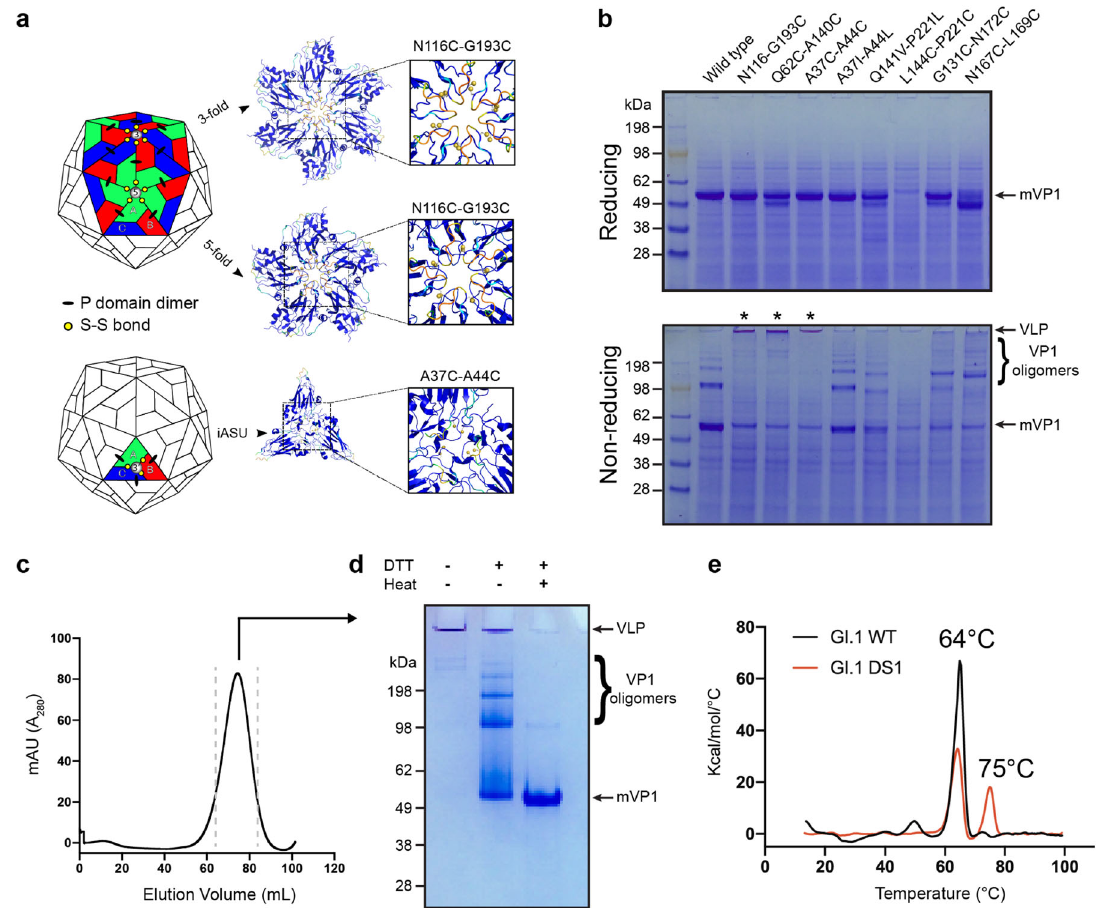
Fig. 2 Structure-based design of interprotomer disul fi des between VP1 monomers leads to stabilized particles with increased thermal stability of the shell domain. a Two strategies can be used to form interprotomer contacts between adjacent VP1 protomers: (1) design of disul fi des (or other intermolecular interactions) at the strict fi vefold and strict threefold symmetry axes (top panel), and (2) design of disul fi des (or other interactions) within the icosahedral asymmetric unit (iASU; bottom panel). One example of each strategy is shown on a portion of GI.1 VLP structure (P domain omitted for clarity). b Screening of eight double-point mutants within GI.1 shell domain after oxidation in diamide. Top gel shows the expression levels of VP1 mutants in reducing conditions. Bottom gel shows the same samples in nonreducing conditions. Asterisks indicate mutants that prevent VLP dissociation (intact VLPs fail to enter the separating gel due to their size). Notice the presence of other VP1 oligomers (dimers, tetramers, and larger species). c Preparative-scale puri fi cation of diamide-treated mutant N116C – G193C (separation performed on Sephacryl S500 column). d Stabilization of the fi nal product tested in reducing and nonreducing conditions. Notice that treatment with reducing agent alone does not entirely dissociate particles into VP1 monomers (middle lane). e Differential scanning calorimetry thermogram of GI.1 WT and oxidized GI.1 DS1. The peak at 64 °C corresponds to the unfolding of the p domain, while the peak at 75 °C corresponds to the unfolding of the shell domain. (In all gels, mVP1 indicates monomeric VP1